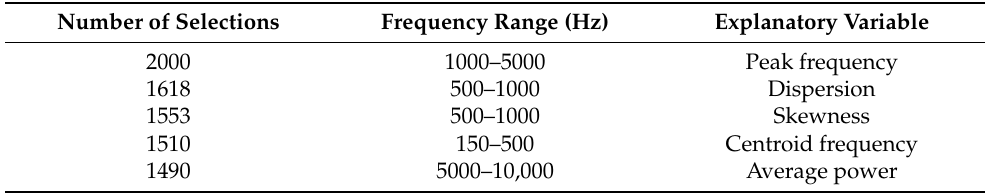
Table 1. Result of explanatory variable selection by Lasso for monoaxial pedicle screw reported in the previous study [10]. These explanatory variables extracted more than 50% of the samples of trials. Number of